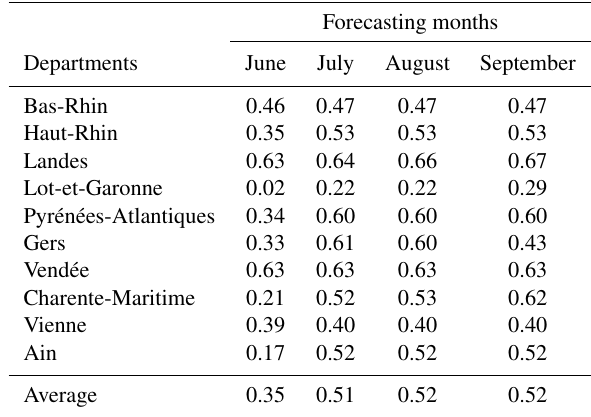
Table 1. The correlation between the observed and estimated yield anomalies for different forecasting months (from June to Septem- ber), over 10 major grain-maize-producing